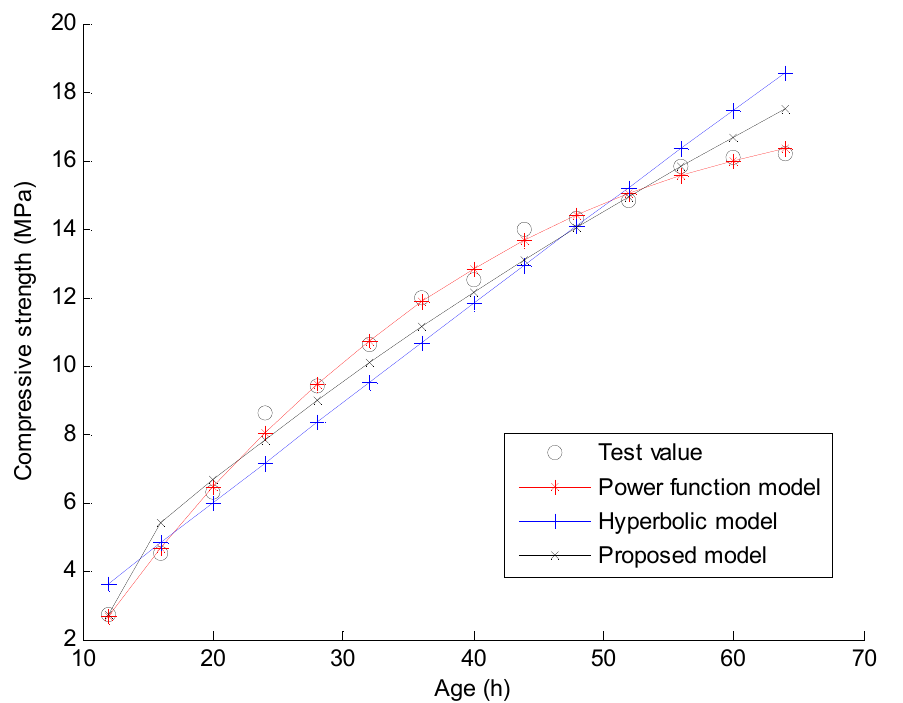
Figure 2. Curve fitting results using the three models for C30 under standard curing.